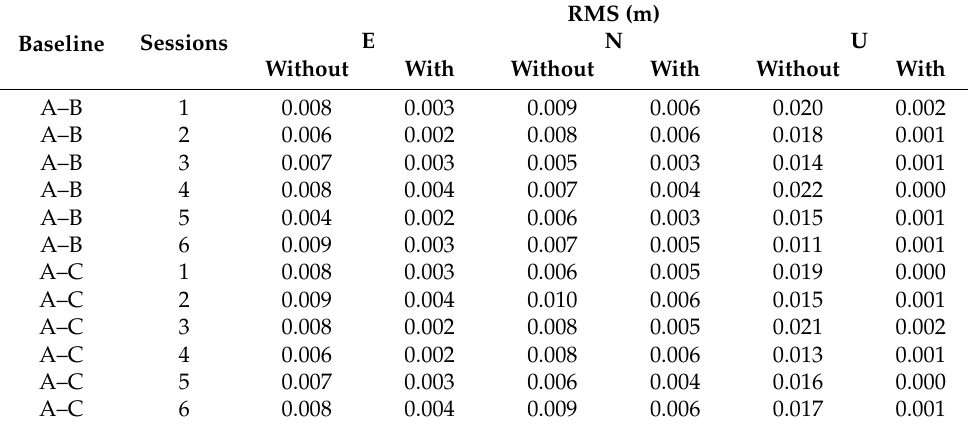
Table 4. RMS statistics of the baseline resolution with and without